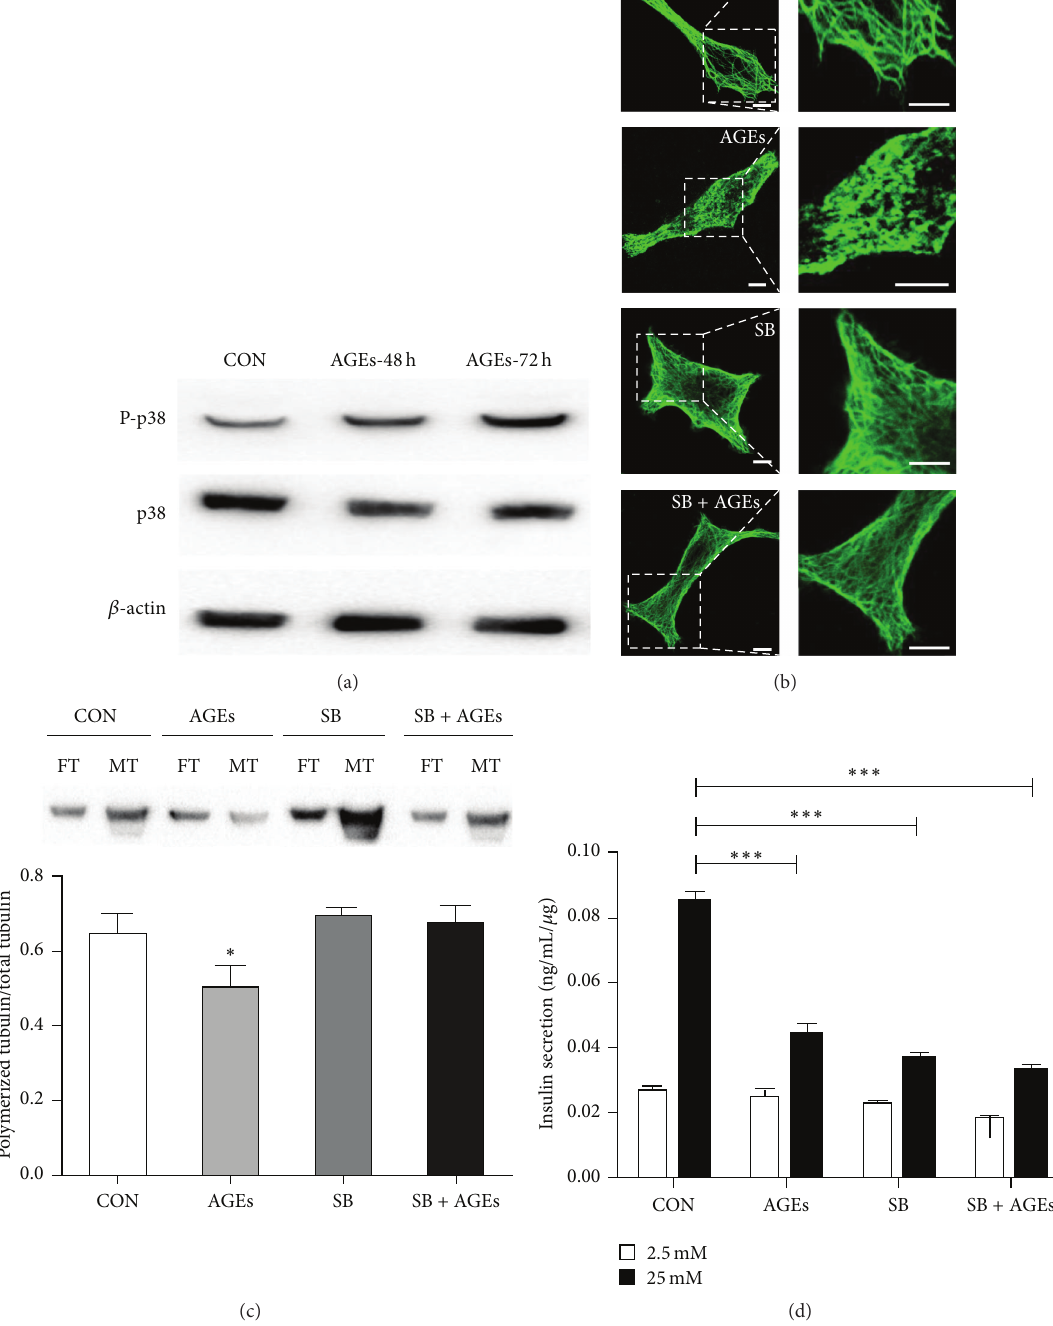
Figure4:AGEsactivatep38/MAPKsignalingpathwaythatdisruptsmicrotubuledynamics.(a)ImmunoblotsofINS-1-3cellsculturedwithout (CON) or with 200 𝜇 g/mL AGEs for 48 hours (AGEs-48h) or 72 hours (AGEs-72 h). The levels of phosphorylated and total p38/MAPK were immunoblotted by phosphospecific and general anti-p38 antibodies, respectively. 𝛽 -actin was used as loading control. (b) Immunostaining images of 𝛼 -tubulin (green) in INS-1-3 cells. INS-1-3 cells were cultured without (CON) or with 200 𝜇 g/mL AGEs in the absence or presence of 50 𝜇 M SB202190 (SB) for 48 hours. The boxed areas are shown at higher magnification in the right panels to illustrate the details of the microtubules. Scale bar: 25 𝜇 m. (c) Quantification of free tubulin (FT) and polymerized tubulin (MT) fractions of INS-1-3 cells by immunoblots. One of the representative results is shown. Statistical analysis was performed based on three immunoblotting results. The polymerization status of tubulin is presented as the percentage of polymerized tubulin divided by the total tubulin content. ∗ 𝑝 < 0.05 ; AGE group versus CON, SB, or SB + AGEs group. (d) Relative insulin secretion from INS-1-3 cells in response to 2.5 mM or 25 mM glucose, normalized to the total insulin content, measured by ELISA. Data were derived from three independent experiments and shown as mean ± SD. ∗∗∗ 𝑝 < 0.001 versus